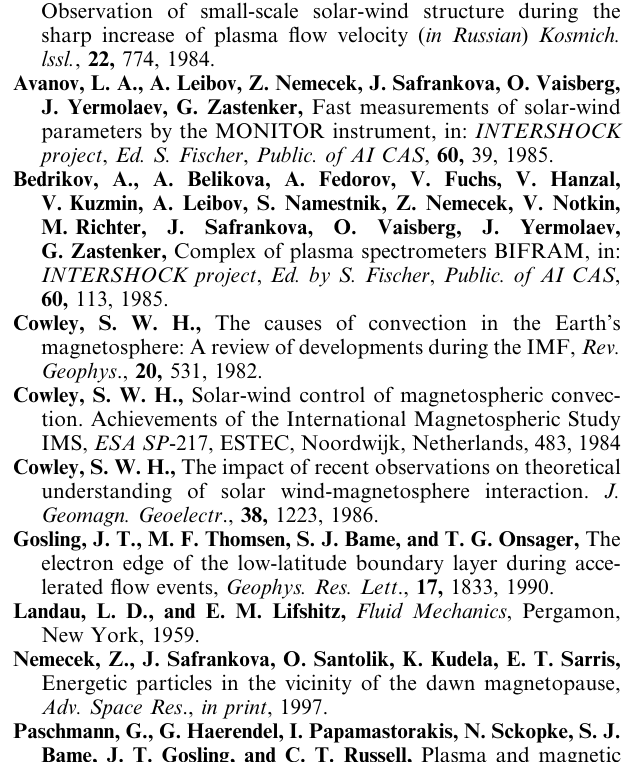
Fig. 10. Comparison of the plasma parameters and magnetic field measured by the INTERBALL 1 and